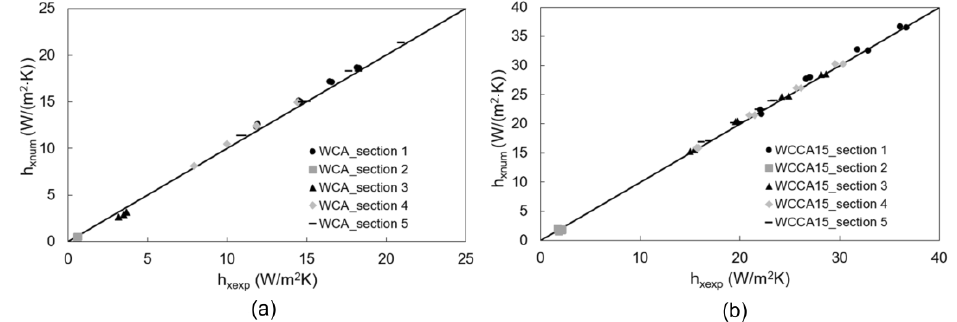
Figure 4. Comparison between the experimental and numerical local heat transfer coefficients for H = 40 mm, T s = 318.15 K, Q = 5 – 20 m 3 /h, ( a ) wavy channel without CVGs, ( b ) wavy channel with CVGs of 15 mm diameter.